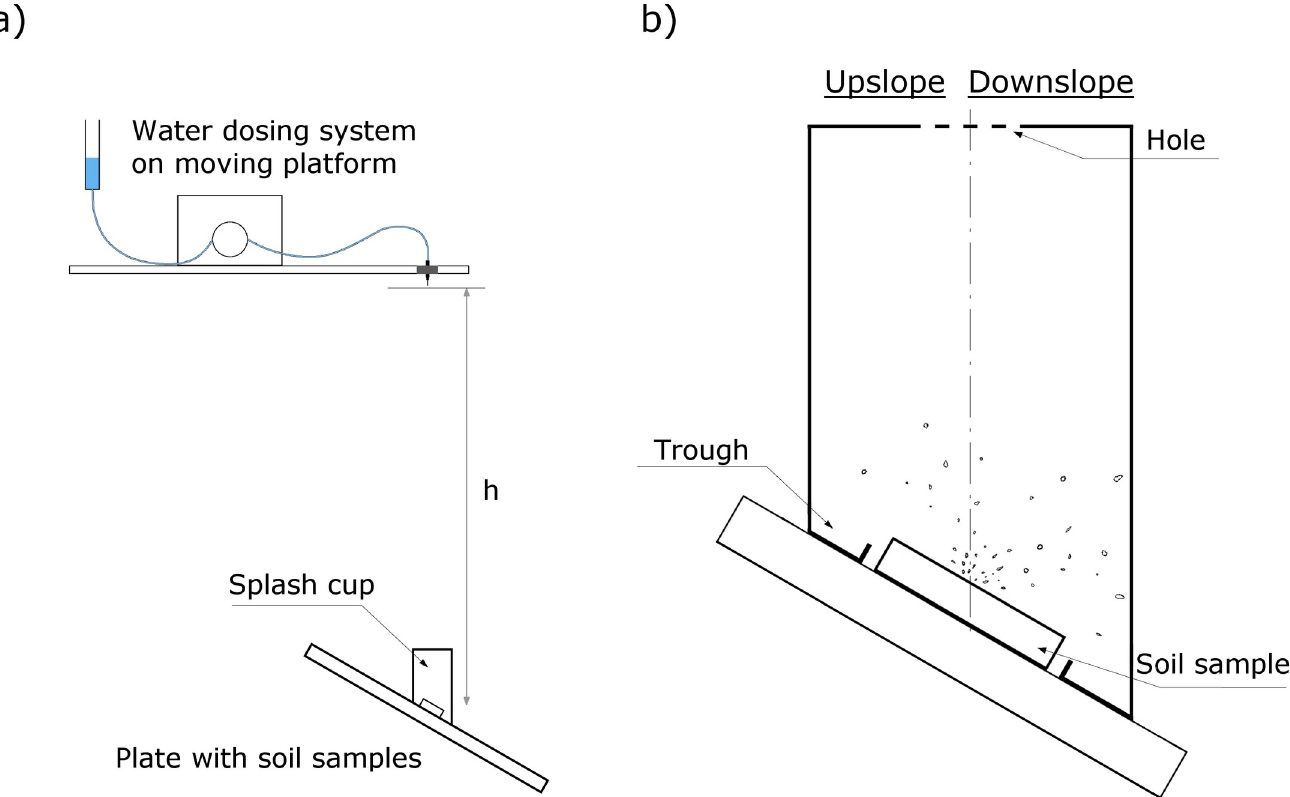
Fig 1. Scheme of the experimental setup (a) and drawing of the used splash cup (b). The dotted line in figure (b) marks the place where the cup is divided into the upslope and downslope parts.